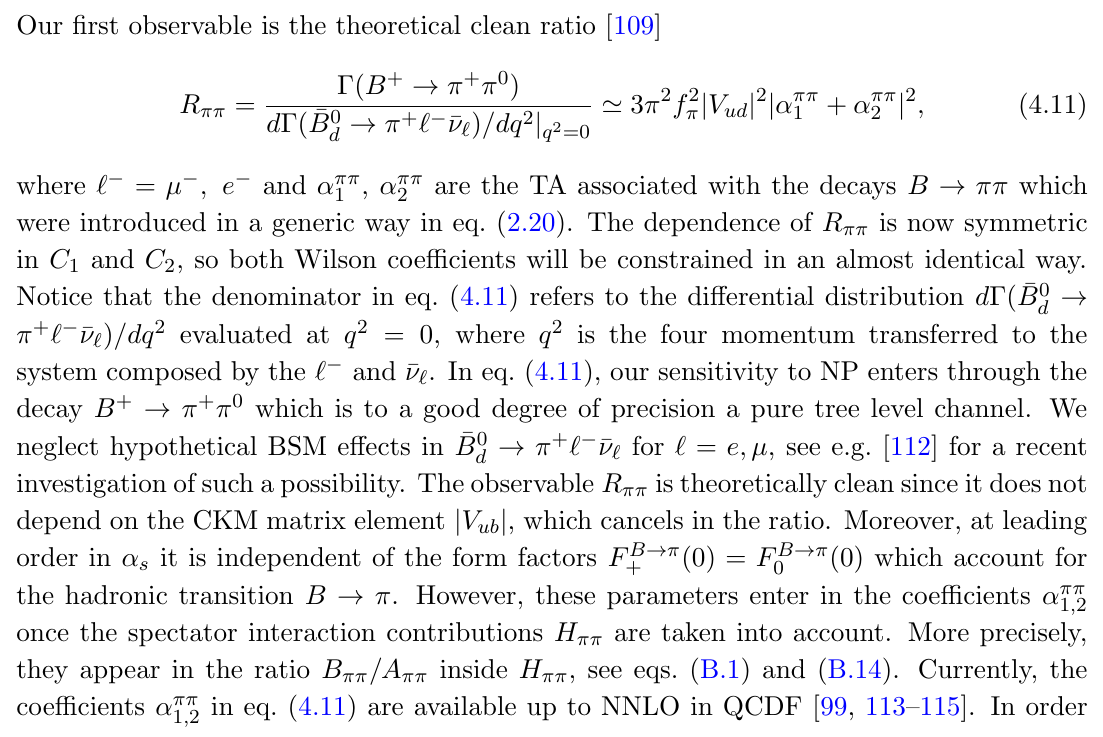
( M W ) and (cid:1) C d;cu ( M W ) 1 2